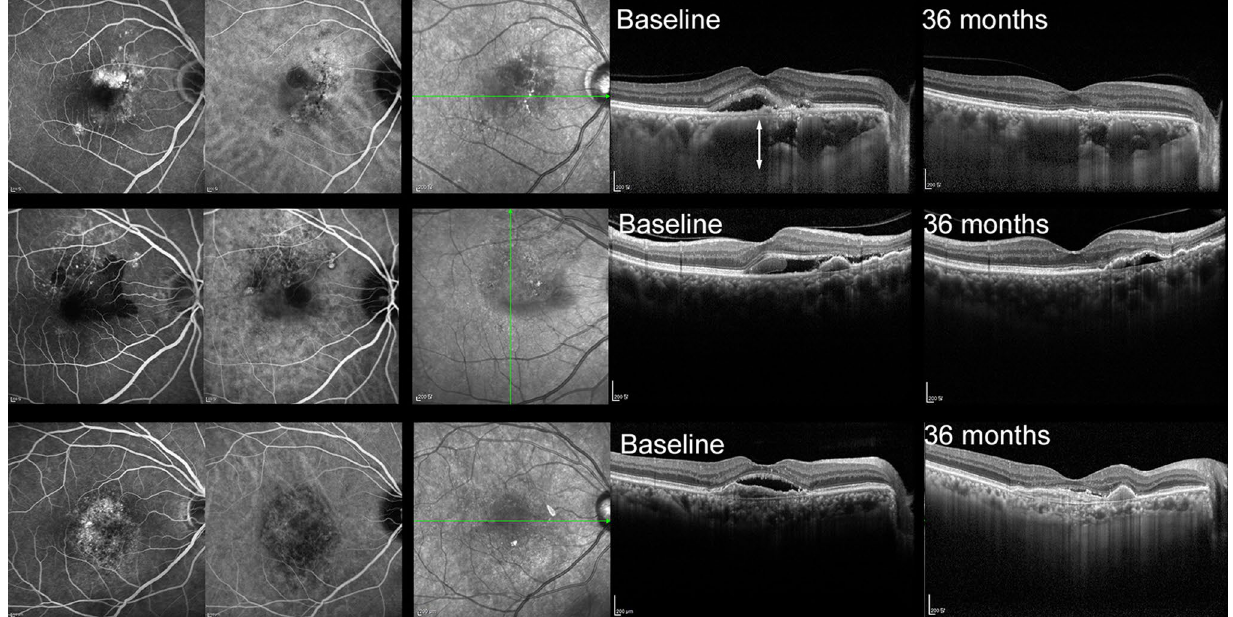
Figure 1. Representative cases of pachychoroid neovasculopathy (PNV), polypoidal choroidal vasculopathy/ aneurysmal type 1 neovascularization (PCV/AT1), and typical neovascular age-related macular degeneration (nAMD) treated with anti-vascular endothelial growth factor. (upper line) A 56-year-old male patient with PNV treated with only 7 injections of aflibercept with 36 months of follow-up. A dilated choroidal vessel is noted under the macular neovascularization (upper line, second image, between the white arrowhead). (middle line) A 66-year-old male patient with PCV/AT1 treated with 12 injections of aflibercept injection over 36 months. (bottom line) A 70-year-old male patient with typical nAMD treated with 15 injections of aflibercept over 36